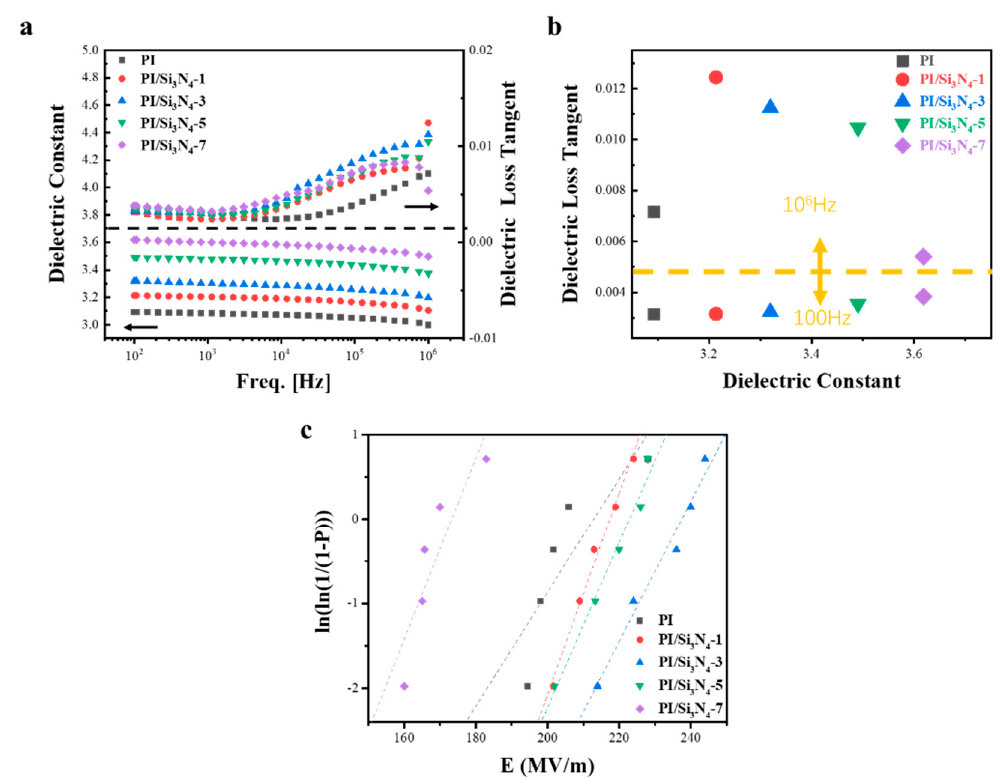
Figure 4. The mass fraction of Si 3 N 4 fillers affecting ( a ) the dielectric constant ( ε ) and dielectric loss tangent (tan δ ) values at a different frequency; ( b ) between dielectric constant ( ε ) and dielectric loss tangent (tan δ ) values at 100 and 10 6 Hz of the PI/Si 3 N 4 composites; and ( c ) Weibull-distribution plot of breakdown strength for PI/Si 3 N 4 composites.